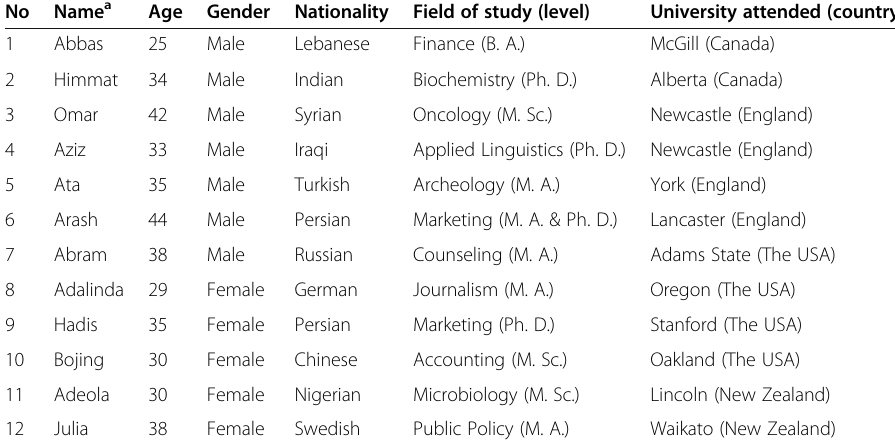
Table 1 Demographic information about the non-native